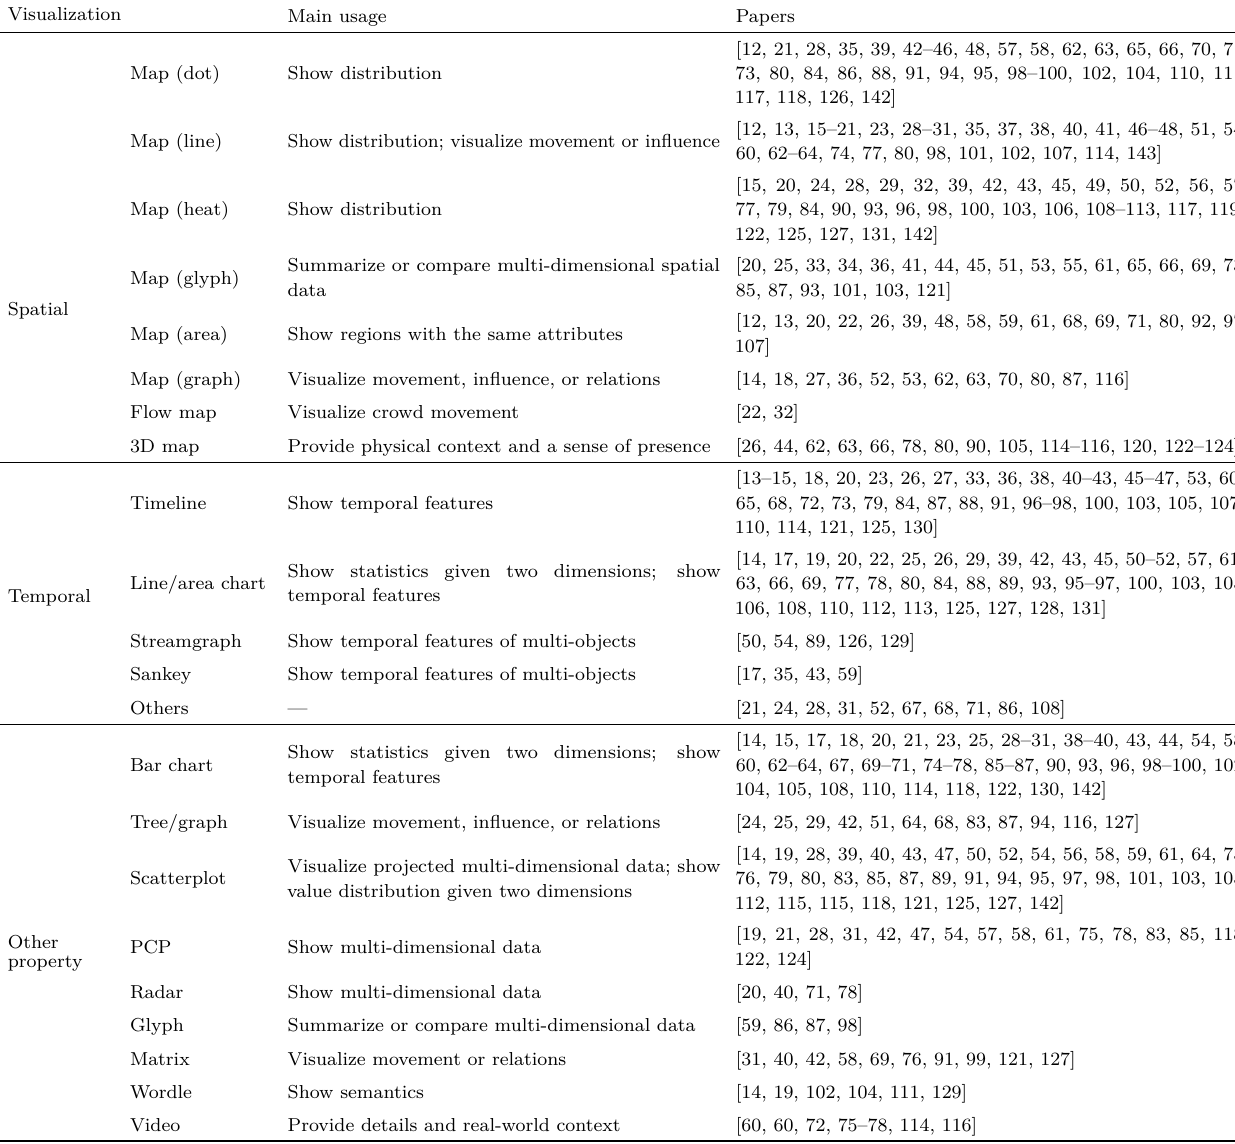
Table 3 Visualizations in urban visual